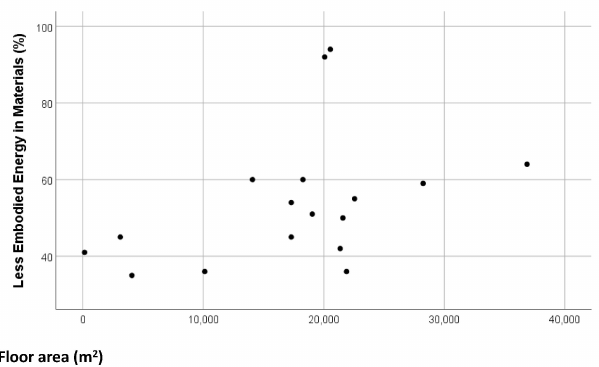
Figure 7. Embodied energy savings in materials per floor area.